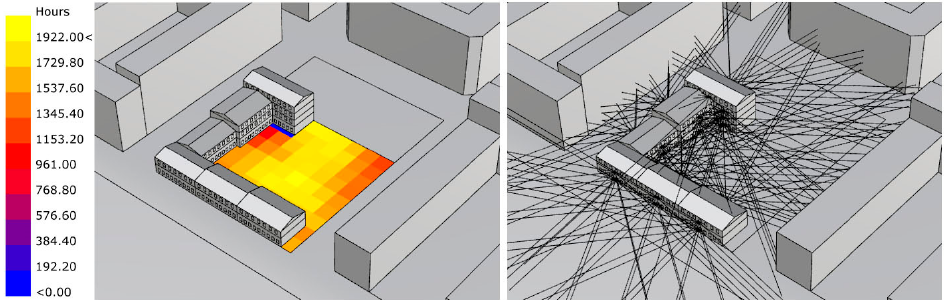
Figure 5. Example of models and evaluation of sunlight hours (left) and views (right) for a solution.